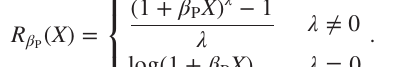
Table 1. E ff ect of omitting covariates on estimated ERR in the Radiation and Breast Cancer Study 95% likelihood Likelihood Estimated SE Covariates omitted bounds ratio P value ERR Adjusted for parity and